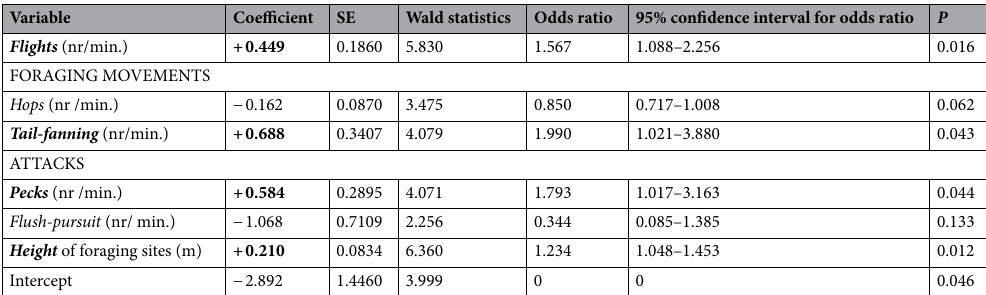
Table 2. Results from the generalized linear model (GLZ) analysis to determine how the probability that the observed foraging sequence belongs to M. miniatus, (i.e. when the binary variable Species have value 1; MYIMIN = 1, MYIMEL = 0), depends on the foraging height and six foraging variables calculated for each foraging sequence ( flights , hops , tail-fanning , pecks , flush-pursuit, flycathing ) as well as the type of foraging site. The table presents the variables present in the best model (GLZ model, dependk = 6; AIC = 72.192; II likelihood Chi-square = 29.300; P = 0.00005). Variables with P < 0.05 are marked bold.